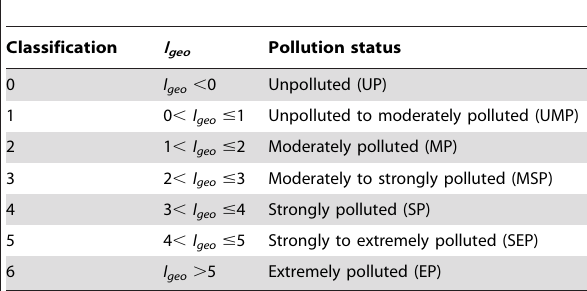
Table 1. Pollution grades of geo-accumulation index of the